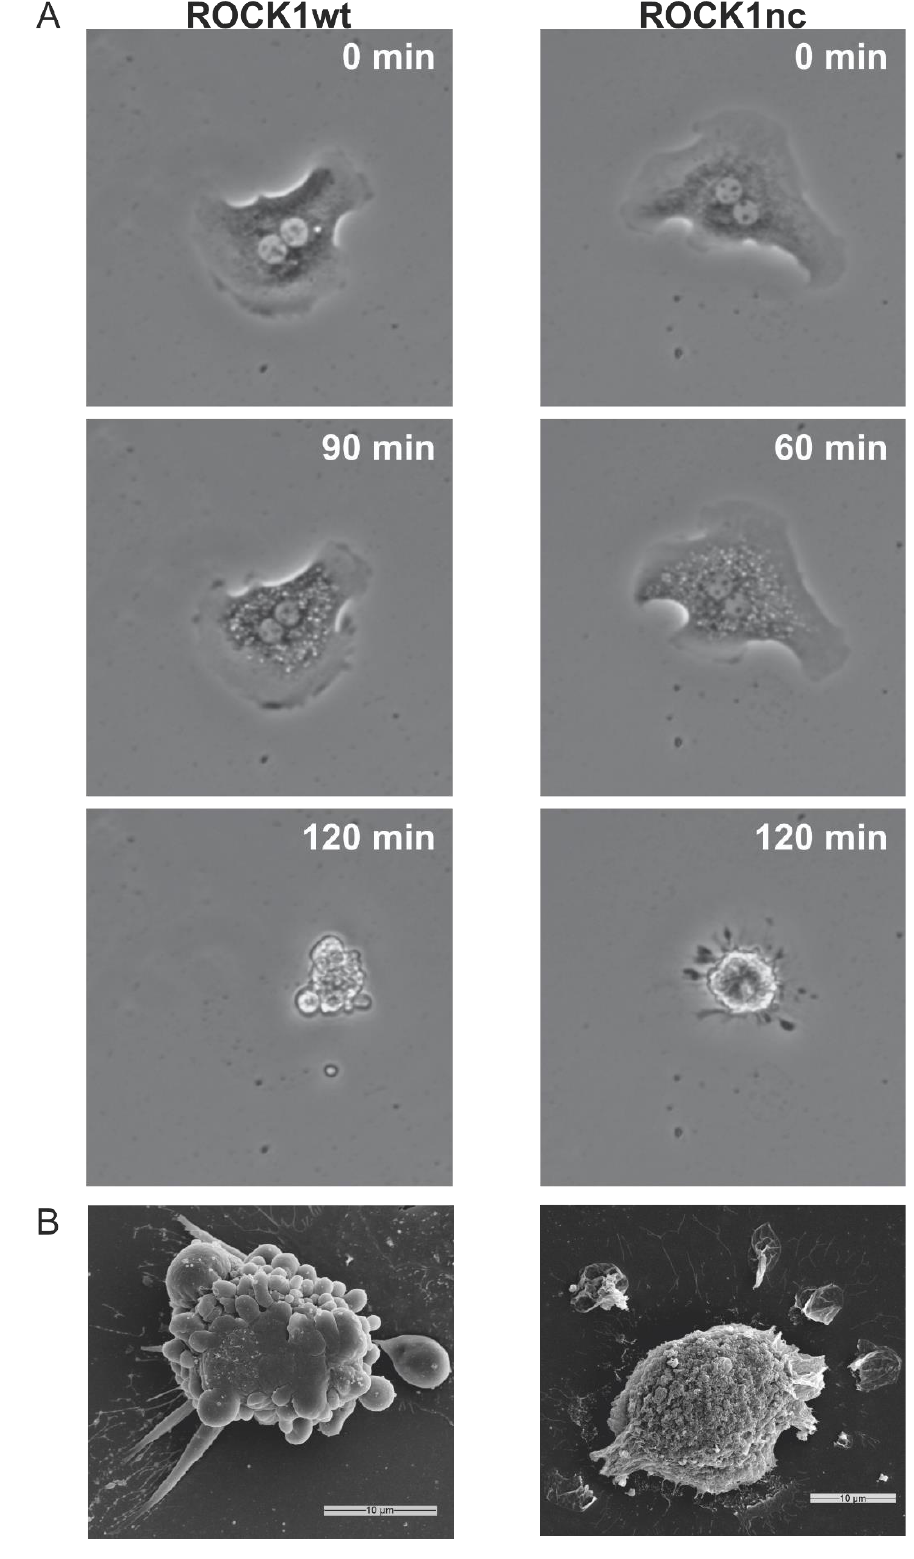
Figure 1. ABT-199 induces a distinct apoptotic morphology in ROCK1nc hepatocytes. ( A ) Representative images of primary hepatocytes isolated from ROCK1wt (left panels) and ROCK1nc (right panels) mice and treated with 1 µM ABT-199 to induce apoptosis. ( B ) Representative scanning electron micrographs of ROCK1wt (left) and ROCK1nc (right) hepatocytes. Scale bars = 10 µm.